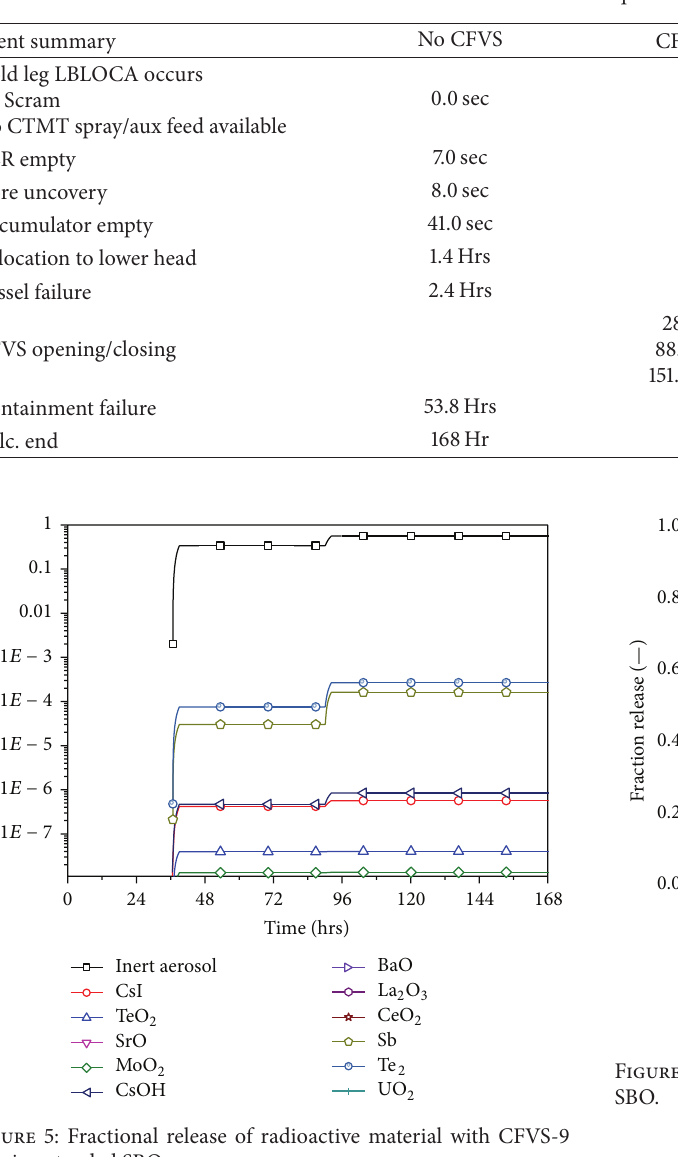
Table 4: LBLOCA sequence of event.